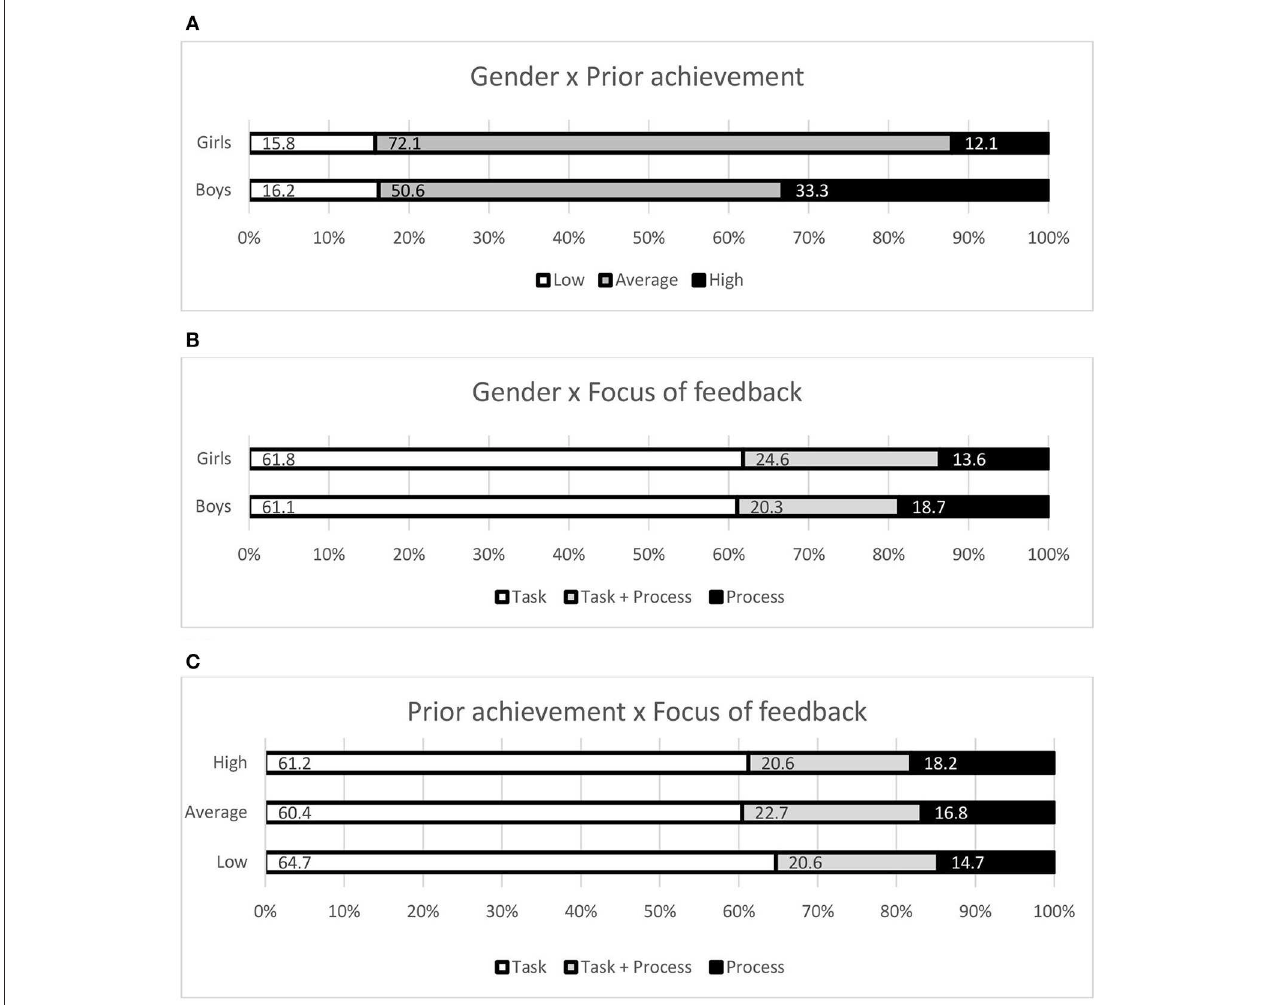
FIGURE 3 | Graphical representation of the association between students’ Gender and students’ Prior achievement (A) , between students’ Gender and the Focus of feedback (B) , and between students’ Prior achievement and the Focus of feedback (C)